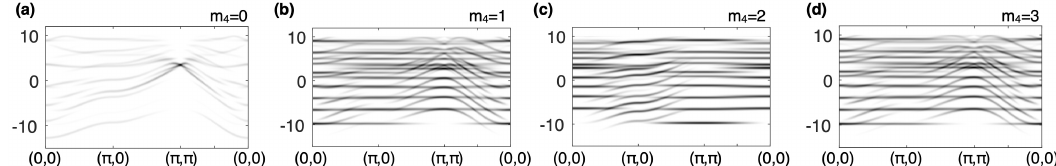
Figure 8: Two-hole spectra for distinguishable holes connected by a string, calcu- lated using the asymmetric approximation, along a high-symmetry cut through the Brillouin zone of the square lattice. The plots are obtained from a spectral decom- position and using our semi-analytical theory with a truncated basis including all m ( 1 ) sectors, up to a maximum string length ℓ and m 3 and a string potential for an Ising